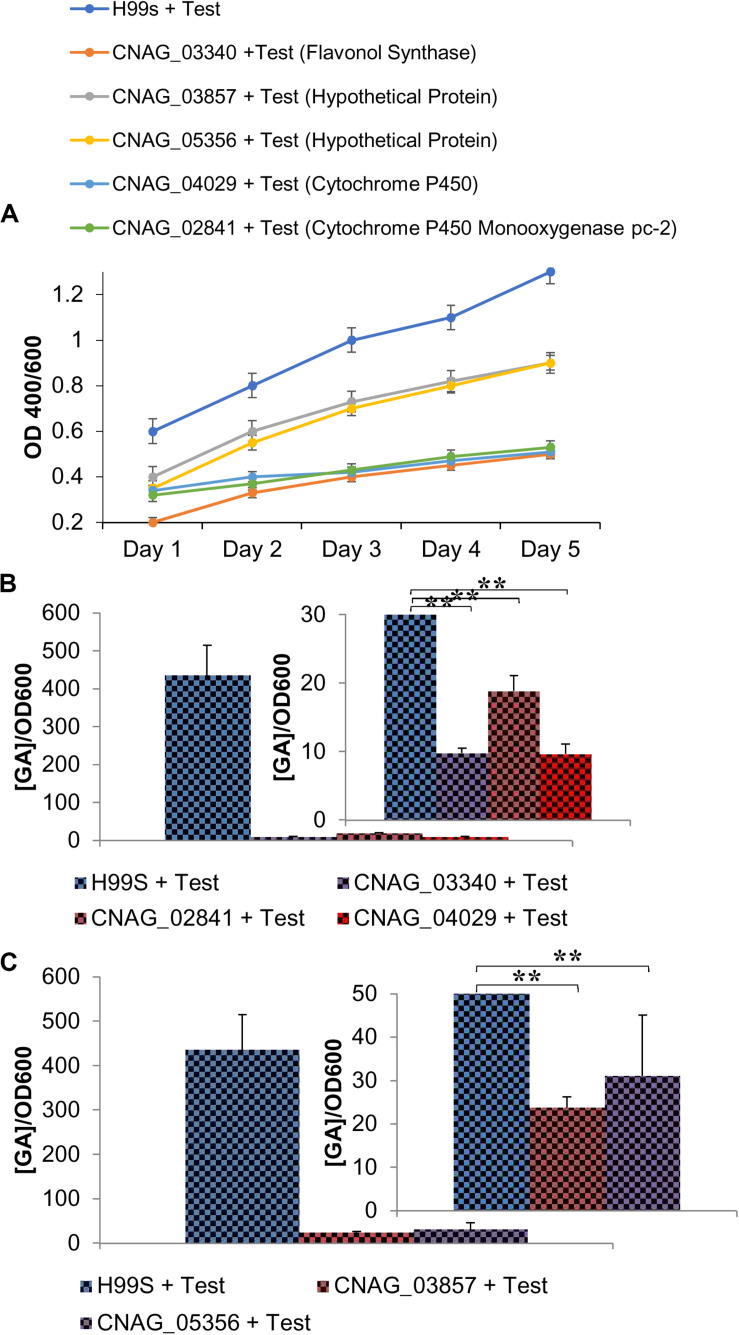
Phenotypic changes when genes involved in the gibberellic acid (GA) pathway are knocked out (KO) of C. neoformans. (A) Melanization of C. neoformans KO strains identified in the RNAseq data. Absorbances were measured at an optical density of 400 and 600 nm. Error bars represent the standard deviation. Data is representative of three independent experiments. Statistical significance is represented as follows: ***p < 0.0001 comparing H99S + Test (10 ng/mL) with all other strains, ***p < 0.0001 comparing strains CNAG_03857 to CNAG_04029, CNAG_5356 to CNAG_04029, CNAG_04029 to CNAG_02841, CNAG_04029 to CNAG_03340, and CNAG_02841 to CNAG_03340 using linear regression. (B) GA concentrations (ng/mL) secreted from KO strains at 32 h of melanization normalized to an optical density of 600 nm. Error bars represent the standard deviation. Data is representative of three independent experiments. Statistical significance is represented as follows: **p < 0.004 using Wilcoxon Rank Sums. (C) Gibberellic acid (GA) concentrations (ng/mL) secreted from KO strains of two hypothetical proteins identified in the RNA sequencing data that were upregulated when C. neoformans was in the presence of testosterone at 32 h of melanization normalized to an optical density of 600 nm. Error bars represent the standard deviation. Data is representative of three independent experiments. Statistical significance is represented as follows: **p < 0.004 using Wilcoxon Rank Sums. Test, Testosterone; Estr, Estrogen (Estradiol); Eth, Ethanol.